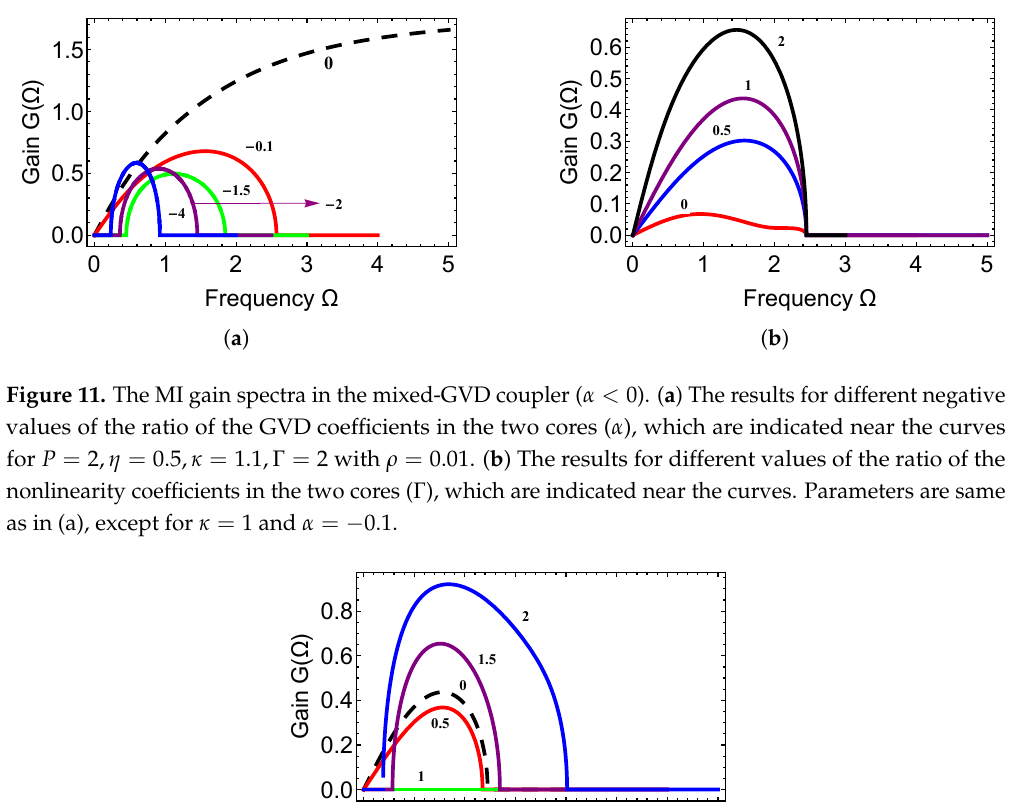
Figure 10. The MI gain spectra for different values of the coupling coefficient, κ (indicated near the curves), in the mixed-GVD coupler ( α < 0) for P = 1, η = 0.7, α = − 0.1, Γ = 2 with ρ = 0.01.